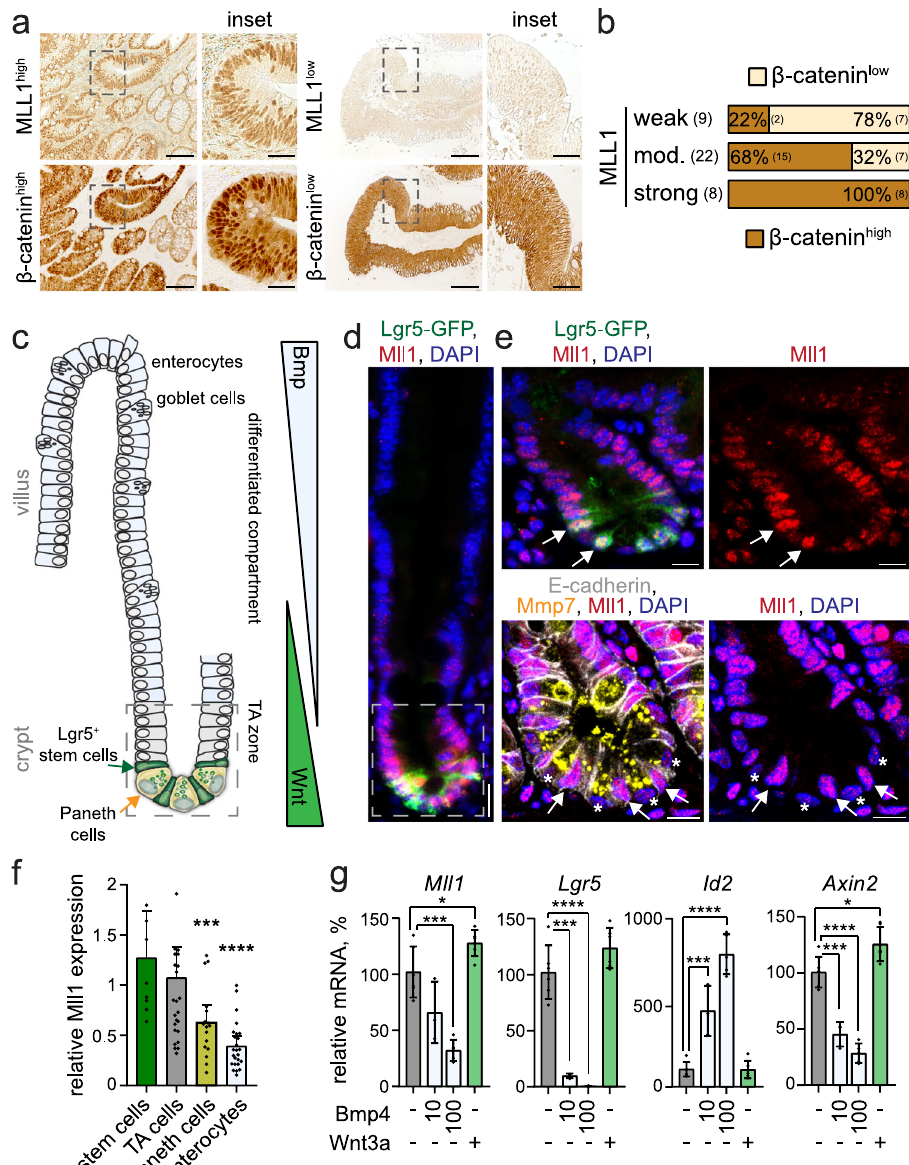
Fig. 1 High Mll1 expression in colon carcinomas and Lgr5 + intestinal stem cells. a Immunohistochemistry for MLL1 (upper panel) and β -catenin (lower panel) of colon cancer patient biopsies, tumor stage T0, scale bar 50 µ m. Insets on the right, scale bar 20 µ m. Stainings were performed on eight independent biopsies. b Quanti fi cation of nuclear β -catenin staining in tumors with strong, moderate, and weak expression of MLL1, scored as low and high across all tumor stages, n = 39 biologically independent colon cancer specimen. Chi-square test for signi fi cance, χ 2 = 11.5, p = 0.0032. c Scheme of the murine small intestine crypt – villus axis 63 . In the lower crypt, Lgr5 + stem cells (green) intersperse between Paneth cells (yellow). Stem cells produce progeny that proliferate and differentiate in the transit-amplifying (TA) zone. Terminally differentiated cells, e.g. enterocytes and goblet cells, move into the villus. Opposing gradients of Wnt and Bmp signaling specify proliferation and differentiation along the crypt – villus axis. d Representative immuno fl uorescence staining for Mll1 (red) on the small intestine of Lgr5-GFP mice reveals a gradual decrease in Mll1 expression from the crypt to villus. Stem cells marked by Lgr5-GFP (green), nuclei in blue (DAPI), scale bar 20 µ m. Stainings were performed in fi ve independent mice. e Magni fi cation of the crypt region; upper panel, arrows mark stem cells with high Mll1 expression (red); bottom panel, asterisks mark Paneth cells stained by Mmp7 (yellow) with low Mll1 expression. E-cadherin (white) stains cell borders. Nuclei in blue (DAPI), scale bar 10 µ m. f Quanti fi cation of Mll1 staining intensity in nuclei of crypt and villus cells, normalized to the mean Mll1 expression in TA cells located just above the stem cell niche (up to relative + 8 position), quanti fi ed from independent stainings of fi ve mice. Data are presented as mean values± 95% con fi dence interval, outliers are shown as single dots. Mann – Whitney test (two-tailed) for signi fi cance relative to stem cells, *** p = 0.0009, **** p < 0.0001. g Mll1 , Lgr5 , Id2, and Axin2 mRNA expression in intestinal organoids of mice treated with 10 ng/ml and 100 ng/ml Bmp4 and 0.66 µ g/ml recombinant Wnt3a for 24 h, n = 6 independent experiments for control and Wnt3a, n = 3 for 10 ng/ml Bmp4, n = 5 for 100 ng/ml Bmp4, two-tailed unpaired t -test, Mll1 * p = 0.0329, *** p = 0.0001; Lgr5 **** p < 0.0001, *** p = 0.0004; Id2 **** p < 0.0001, *** p = 0.0008; Axin2 * p = 0.0136, **** p < 0.0001, *** p = 0.0005. Data are presented as mean values± SD. Source data are provided as a Source Data fi